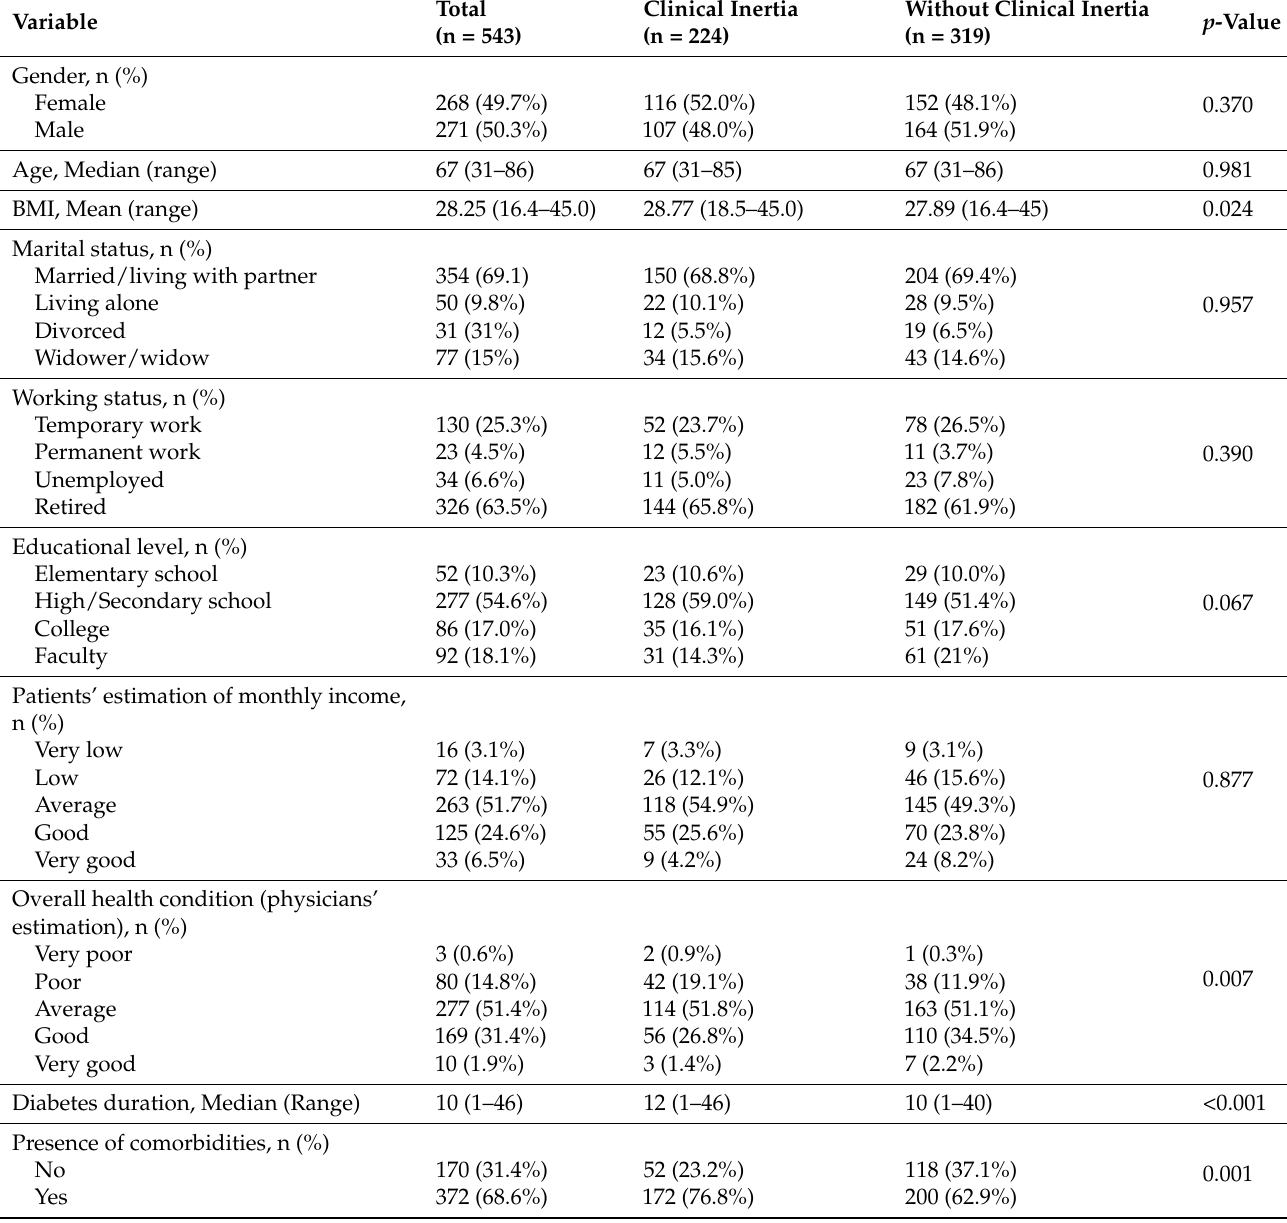
Table 1. General characteristics of participating patients and related clinical